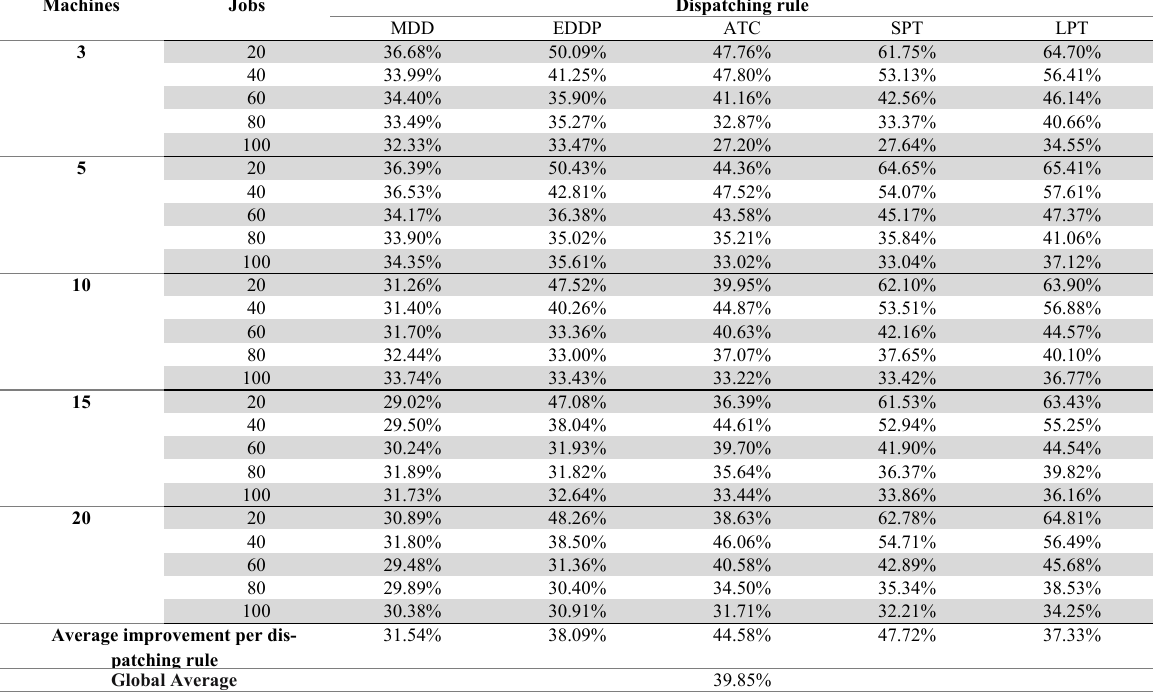
Improvement average resume of the GA